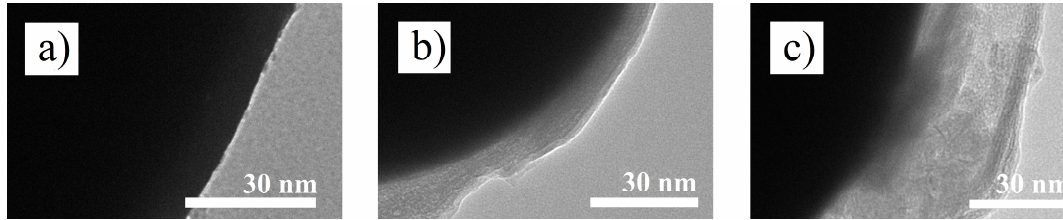
Figure 2. TEM images of ( a ) bare CI, ( b ) CI- g -PHEMATMS-1, and ( c ) CI- g -PHEMATMS-2 showing a part of the corresponding single particle.